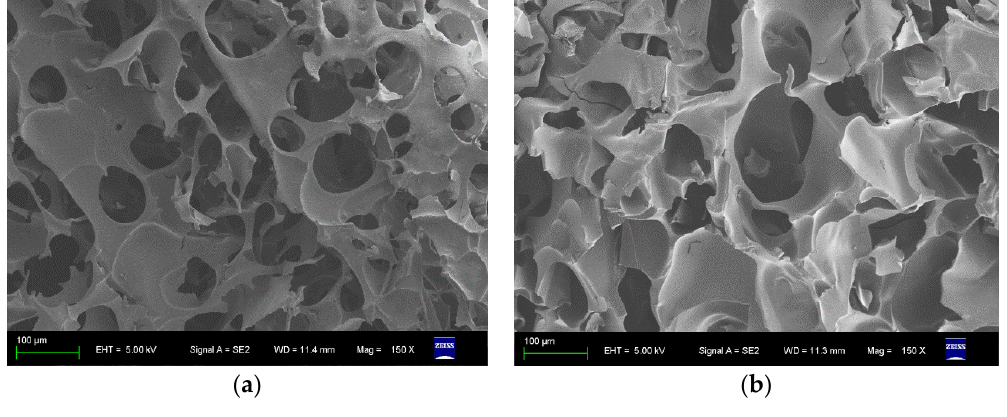
Figure 1. SEM images of ( a ) MIP; and ( b ) NIP.